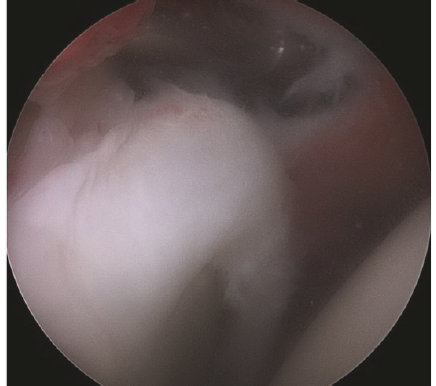
Figure 4: Intraoperative arthroscopic image from the posterior portal, demonstrating absence of origin of the long head of the biceps tendon and presence of the superior